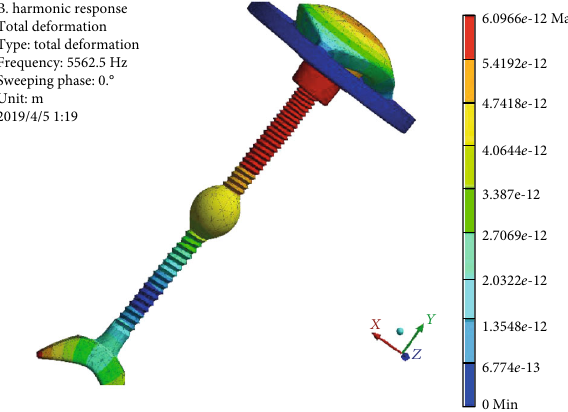
Figure 12: Displacement cloud diagram of the prosthesis with aluminum alloy ball.